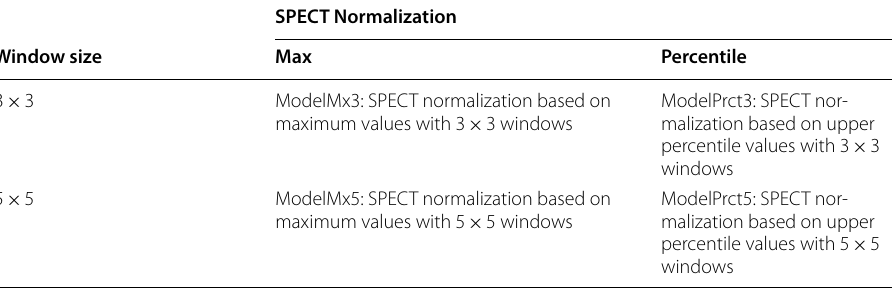
SPECT Normalization